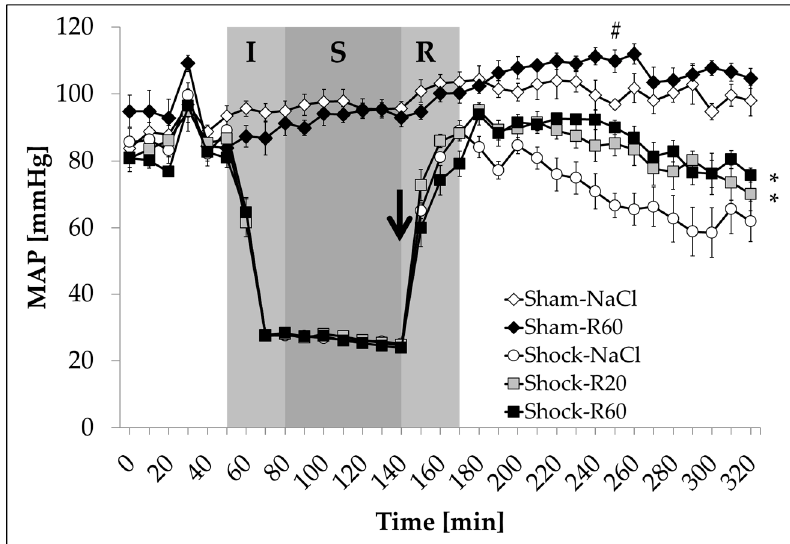
Figure 2. Effect of continuous intravenous infusions of solvent-free low-dose resveratrol on mean arterial blood pressure (MAP) subsequent to severe hemorrhagic shock in rats. Rats underwent severe hemorrhage (30 min shock induction, I; 60 min shock phase, S), then were resuscitated (within 30 min, R) with the withdrawn blood and lactated Ringer’s equal to twice the volume of the withdrawn blood in the absence (Shock-NaCl) or presence of resveratrol (20 or 60 µ g/kg × h until the end of the experiment; Shock-R20, Shock-R60) and observed for a further 150 min. Sham animals received either pure 0.9 % NaCl solution (Sham-NaCl) or the higher resveratrol dose (Sham-R60). Mean arterial blood pressure (MAP) was measured in the right femoral artery every 10 minutes. Shown are mean values ± SEM ( n = 8 animals per group). SEM values not visible are hidden by the symbols. * p < 0.05 (vs. Shock-NaCl). # p < 0.05 (vs. Sham-NaCl; entire period from the resuscitation). The arrow indicates the start of the resveratrol